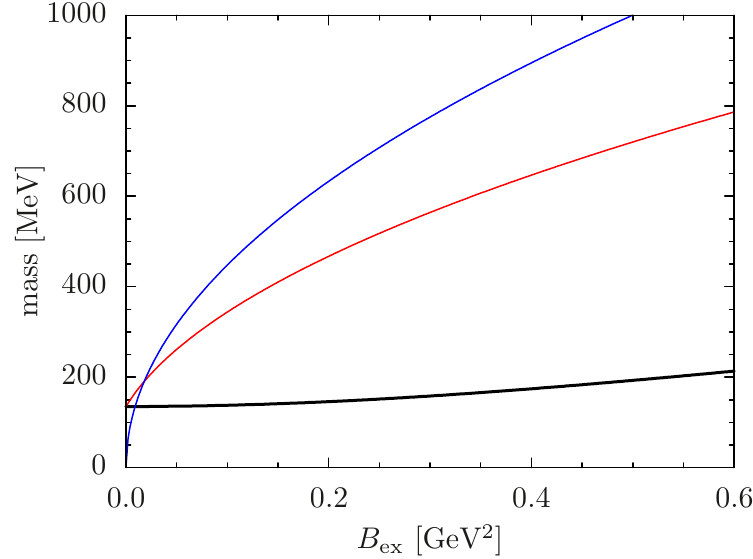
Figure 5 . Comparison of various energy scales in our system as a function of the external magnetic (cid:12)eld. The thick black line corresponds to the anomalous neutral pion mass, eq. (3.6). The red line stands for the charged pion mass, lifted by the magnetic (cid:12)eld as a consequence of Landau level quantization. Finally, the blue line indicates the threshold for the dilepton ( e + e (cid:0) ) decay of the neutral pion in presence of the external magnetic (cid:12)eld. There is clearly a range of magnetic (cid:12)elds in which the pion spectrum features scale separation, that is, the neutral pion is considerably lighter than the charged pion. For illustration, demanding that the ratio of the pion masses is at most 1 = 2 requires that 0 : 06 GeV 2 . B ex . 3 : 2 GeV 2 , or 10 19 G . B ex . 5 (cid:2) 10 20 G. The numerical results were obtained using the vacuum mass m (cid:25) (cid:25) 135